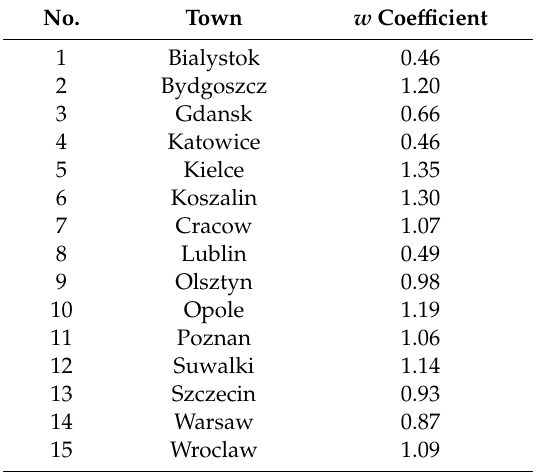
Table 27. w coe ffi cient of non-renewable primary energy in selected large cities in Poland (2019). No.